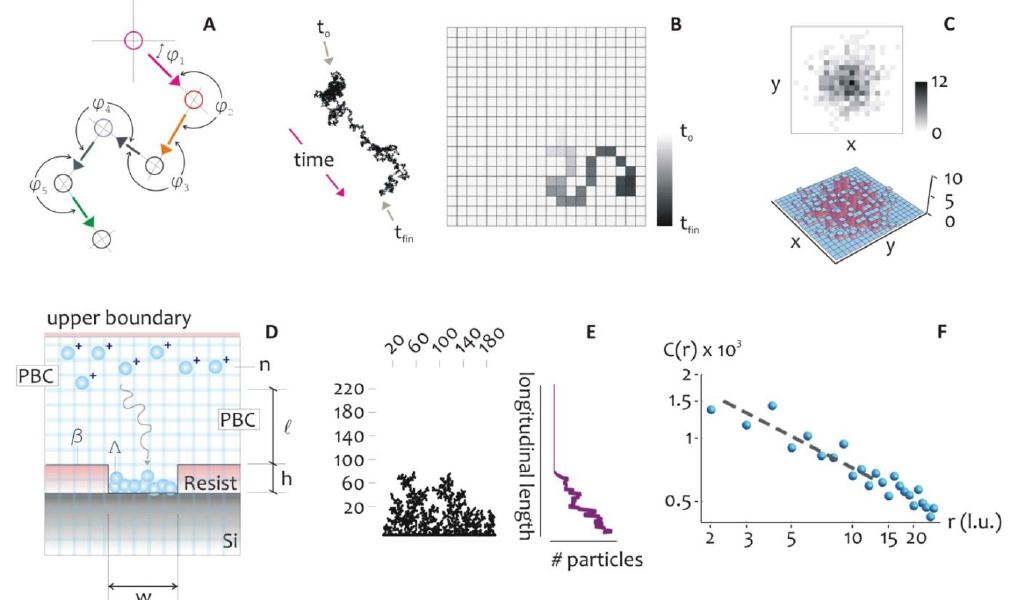
Figure 2. We used a Diffusion Limited Aggregation (DLA) model to simulate the electroless deposition of silver ions into supra-molecular structures. In the model, the trajectory of the particles can be described by a random walk, as to resemble a Brownian motion ( A ). The motion of a particle can be simulated in a regular lattice, where the smallest block of the lattice is called the lattice unit, that represents the spatial resolution of the simulation (that is, a pixel) ( B ). The distribution of displacements of a particle may be described using a Gaussian density function ( C ). This concept was used to simulate the deposition of metal ions in a patterned silicon substrate, ( D ), where a sufficiently large number n of particles is released in the system and let free to evolve. Using this scheme, an aggregate can be formed as in ( E ), where the multi branched arrangement of particles recalls the dendrite, fractal nature that electroless grown systems reveal under certain growth conditions. In ( F ), we report the pair correlation function of a similar numerical aggregate. A pair correlation function describes the change of information content of an aggregate as a function of change in scale and it is typically reported in a log log plot. In the diagram, the y axis represents the correlation function, while the x axis is the distance from the geometrical center of the aggregate expressed in lattice units (pixels). The pair correlation function is therefore related to the probability of finding the center of a particle a given distance from the center of another particle. For short distances, this is related to how the particles are packed together. On calculating the slope of this diagram, the fractal dimension of an aggregate can be